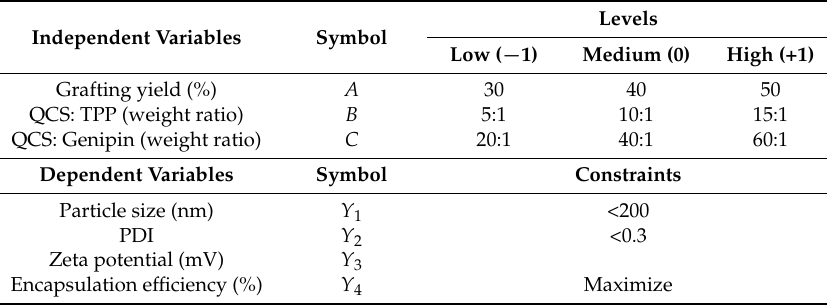
Table 1. Selection of variables and their